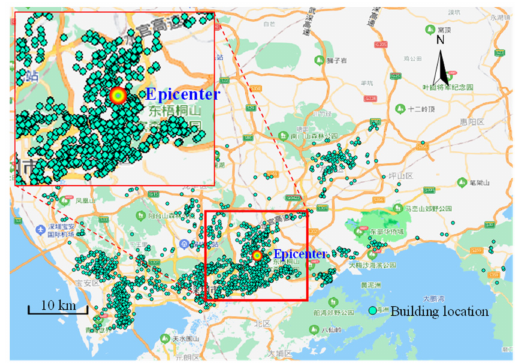
Figure 15. Distribution of studied